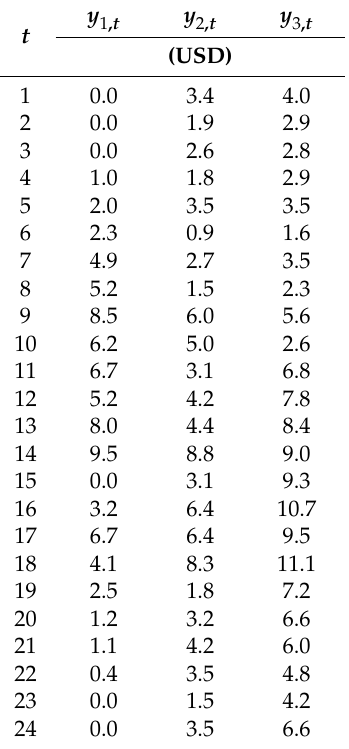
Table 5. Results of the EDR program.